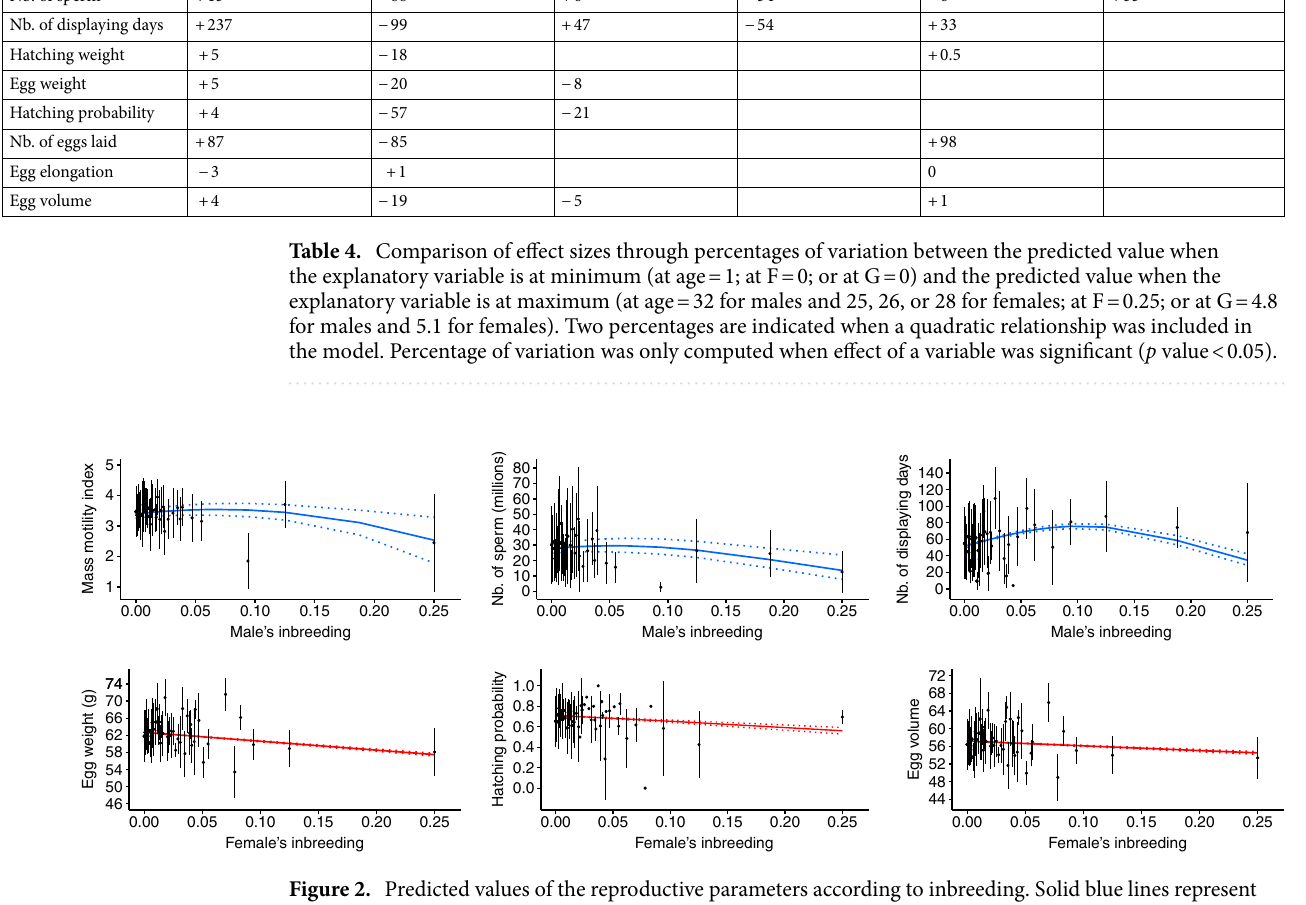
Figure 2. Predicted values of the reproductive parameters according to inbreeding. Solid blue lines represent male reproductive parameters while solid red lines represent female reproductive parameters. Dotted lines represent the 95% confidence intervals. Black filled points represent average phenotypic values computed on raw data and the vertical lines represent the associated standard mentary Figure S2 online. Increasing inbreeding was associated with substantial decreases in the mass motility index (− 28%), number of sperm (− 54%), number of displaying days (− 54%) and hatching probability (− 21%) (Fig. 2; Tables 3, 4). In other parameters, changes were weaker (≤ 8%; in egg weight and egg volume) or not statistically significant (i.e., in hatching weight, in the number of eggs laid and in egg elongation). Relationships between inbreeding F and males’ reproductive parameters were quadratic, and decreases started from F = 0.09 for the mass motility index, from F = 0.06 for the number of sperm and from F = 0.10 for the number of display- ing days (Fig. 2). Larger confidence intervals with increasing F were mainly associated with the low number of highly inbred individuals. The proportion of individuals exhibiting an F equal to or greater than 0.1 ranged from 0.48 to 0.71% depending on the sampling associated with the parameter analyzed. Increasing number of generations in captivity was associated with increases in the mass motility index (+ 10%), number of sperm (+ 33%), number of displaying days (+ 33%) and number of eggs laid (+ 98%) (Tables 3; 4; Fig. 3). Changes were marginal in hatching weight (+ 0.5%), egg volume (+ 1%) and egg elongation (~ 0%), and not significant in either egg weight or hatching probability (Table 3). When comparing size effects (Table 4), decreases in reproduc- tive parameters according to age were greater (i.e., larger percentage of variation after senescence onset) than changes according to inbreeding and number of generations in captivity except for the number of eggs laid, where the 85% decrease according to age was of the same magnitude as the 98% increase according to number of generations in captivity.